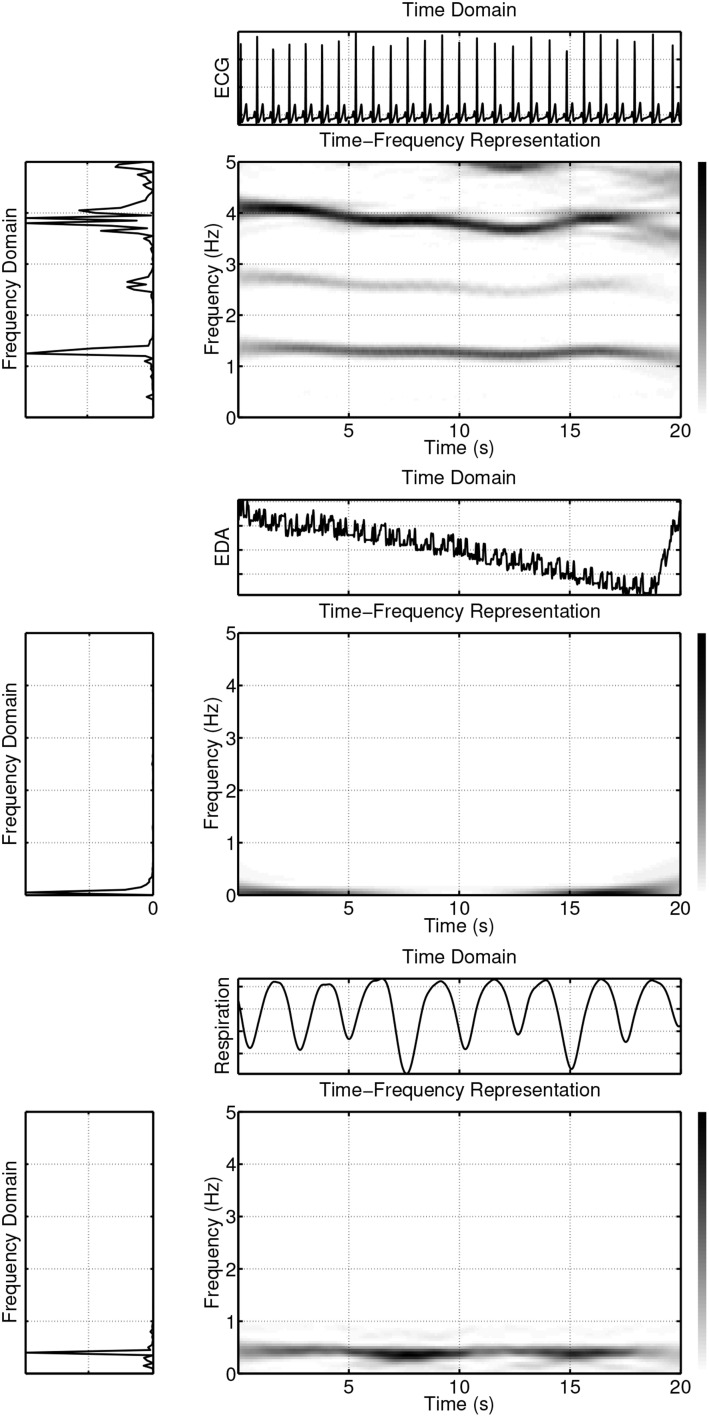
Example of ECG, EDA and respiration signals in time, frequency and time-frequency domains.